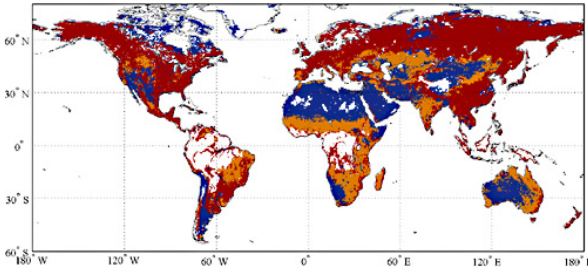
Fig. 11. Spatial coverage by AMSR-E (blue), ASCAT (red) and the merged product (orange). Tropical rain forests are masked out due to their high vegetation